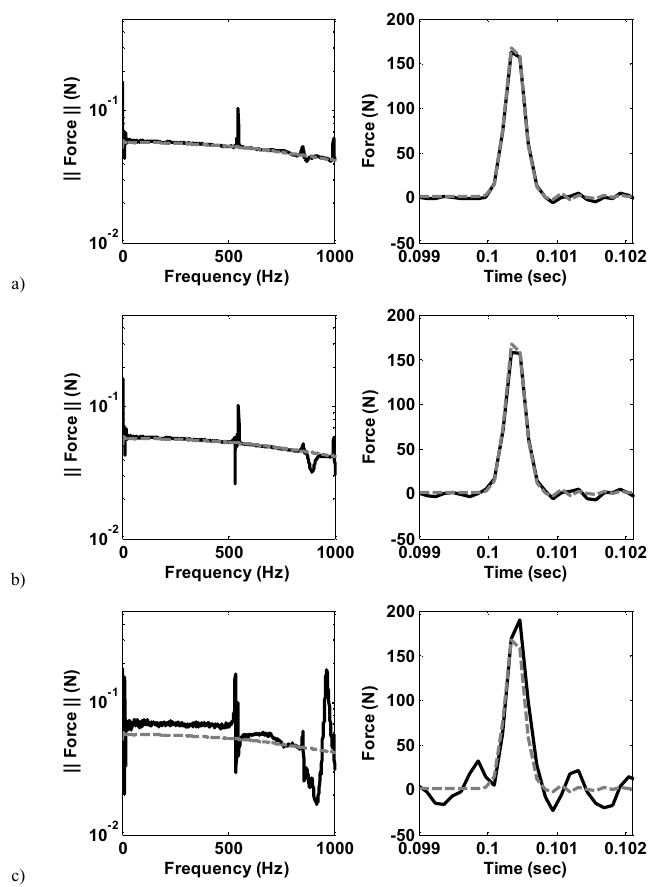
Fig. 15. Comparison of estimated force (——) and actual force (– – –) when a) three, b) two, and 3) one response measurement(s) is(are) included in the system of equations. The number of response measurements included in Eq. (1) when quantifying the force at the final forcing DOF is varied in order to determine how the accuracy of the force estimate is dependent on the degree to which Eq. (1) is overdetermined. Because a triaxial accelerometer is used to capture the structural responses of the RMC, one, two, or three response measurement(s) can be included in the force estimate calculation. The force estimate for the force at Point 1 previously described is shown in Fig. 15 when the number of response measurements in Eq. (1) is varied. For simplicity, when one response measurement is used, the X -direction data are utilized, and when two response measurements are used, the X - and Y -direction data are